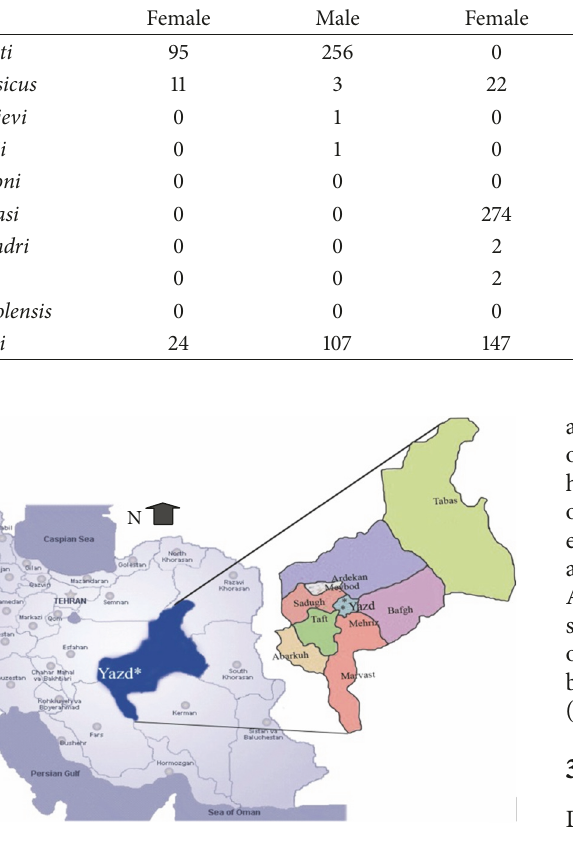
Figure 1: Map of study